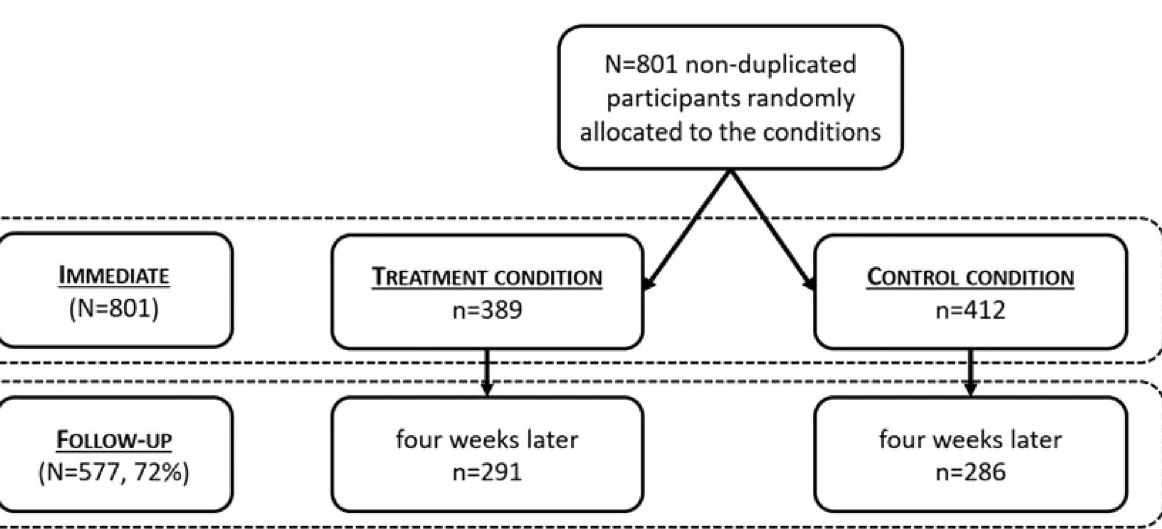
Figure 1. Sample characteristics and